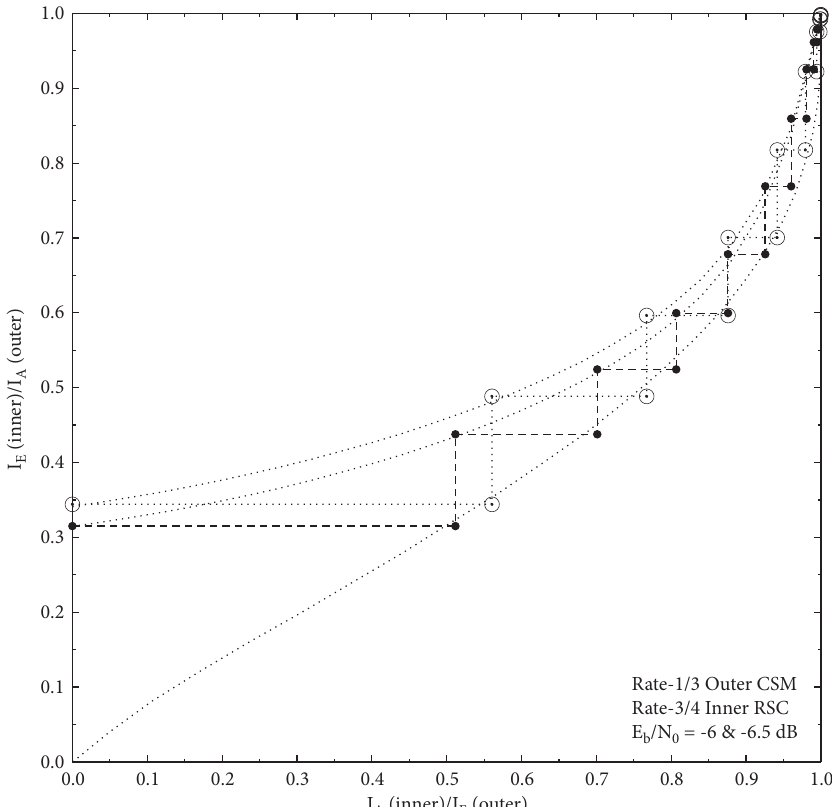
Figure 5: EXIT chart curves and decoding trajectories for Rate-2/6 CSM ( Mapping-II ) scheme.